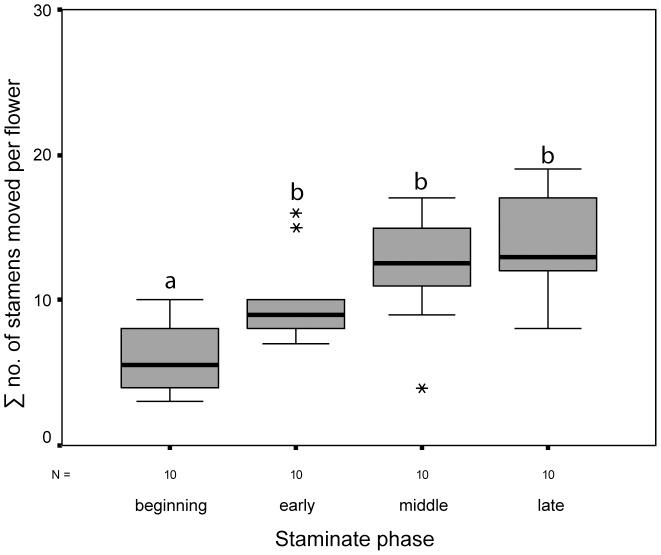
Stem and leaf plot of data for the different flower ages incl. extremes (*) in Nasa urens.Different letters indicate significant differences between the amount of stamens moved (gls model; P<0.05, Supporting Information S1).